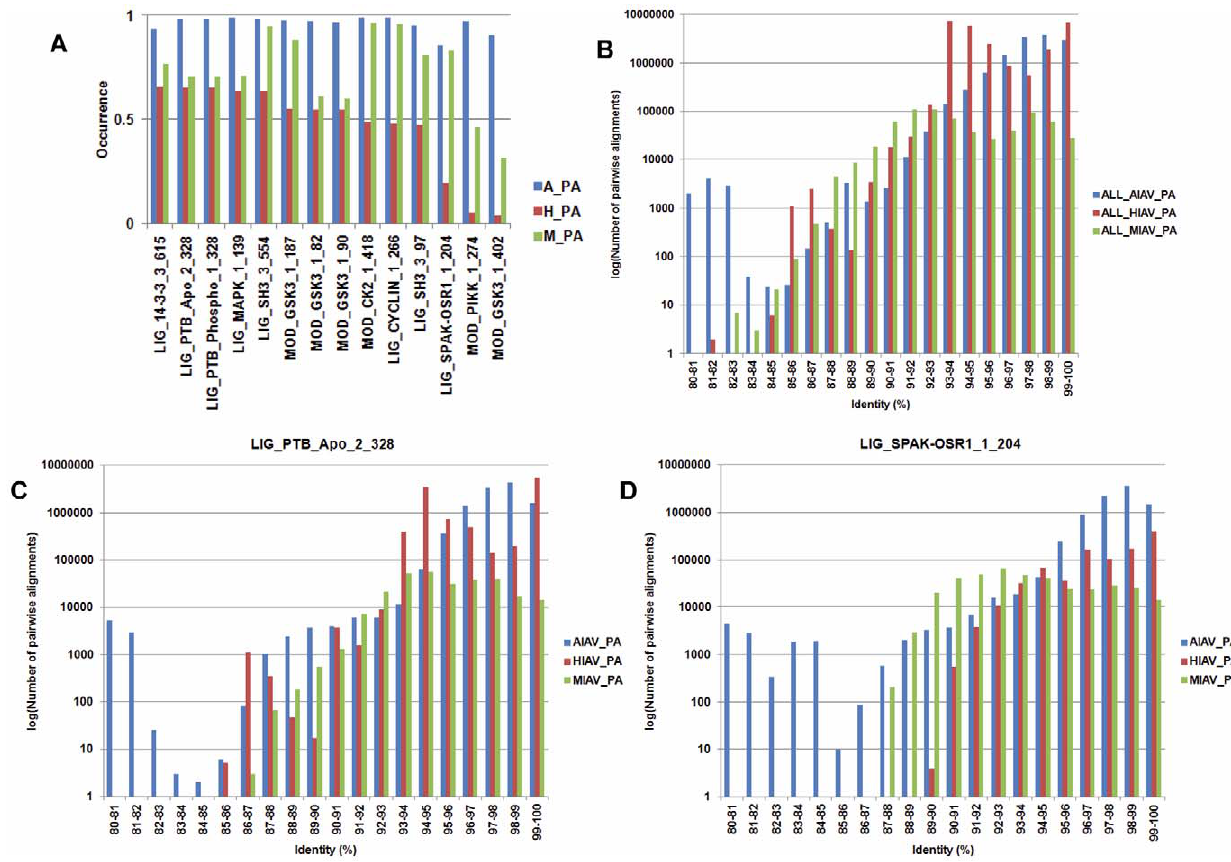
Figure 2. SLiMs from IAV PA proteins that have a differential occurrence in IAVs from different hosts. (A) 14 SLiMs that have a differential occurrence in IAV PA proteins from different hosts. A_PA, H_PA and M_PA indicate the PA proteins from avian, human and IAV, respectively. The Y-axis indicates the occurrence of each identified SLiM. The X-axis indicates the name and position of each identified SLiM in the PA proteins. For example, ‘‘LIG_14-3-3_3’’ in ‘‘LIG_14-3-3_3_615’’ is the name of the SLiM, and 615 is the amino acid position where the SLiM starts. (B) The distribution of pairwise alignment identity of all PA protein sequences from avian, human and mammalian IAVs. (C) The distribution of pairwise alignment identity of PA protein sequences which harbor the SLiM LIG_PTB_Apo_2_328 from avian, human and mammalian IAVs. (D) The distribution of pairwise alignment identity of PA protein sequences which harbor the SLiM LIG_SPAK-OSR1_1_204 from avian, human and mammalian IAVs. For B, C and D, the X-axis indicates the number of pairwise alignments of IAV PA protein sequences. The Y-axis indicates the identity of pairwise alignment (the percentage of identical amino acids that are the same in both PA sequences). Blue: PA protein sequences from avian IAVs. Red: PA protein sequences from human IAVs. Green: PA protein sequences from mammalian IAVs.